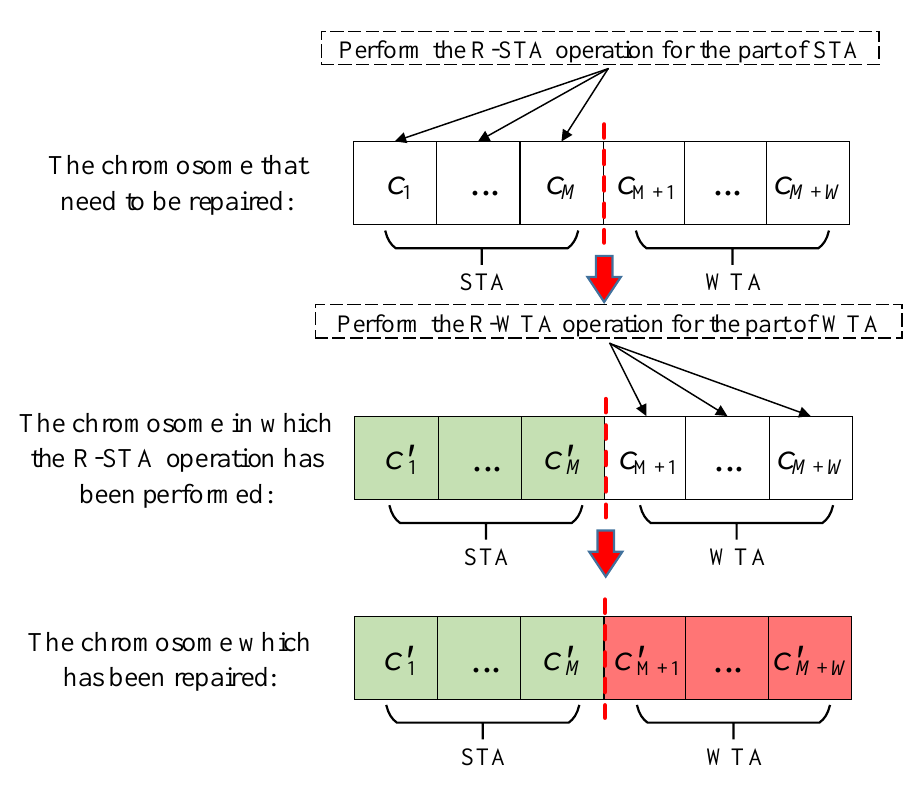
Figure 8. The illustration of the process of the repair